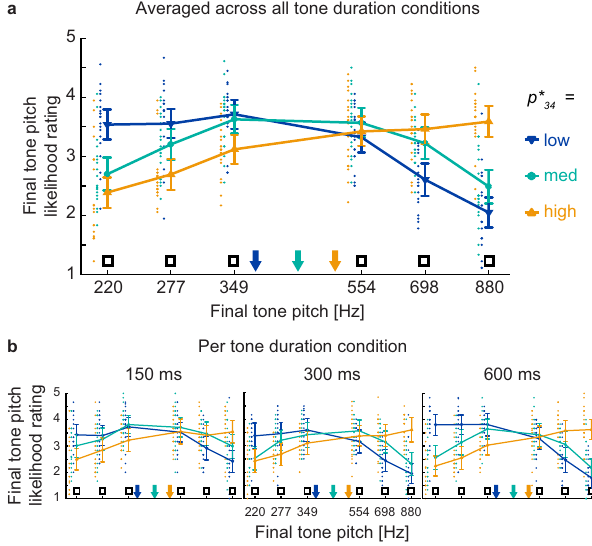
Fig. 2 Subjects ’ behavior demonstrates effective fi nal tone pitch prediction ( n = 20 participants). a Final tone pitch likelihood ratings averaged across all tone duration conditions. Final tone pitch likelihood rating ( y -axis; 1 = unlikely, 5 = likely) is plotted as a function of presented fi nal tone pitch ( p [empty black squares], x -axis) and theoretically 34 predicted fi nal tone pitch ( p (cid:2) ; color-coded). p (cid:2) tone pitch is indicated on 34 34 the x -axis by color-coded arrows. A repeated-measures ANOVA shows a signi fi cant interaction between p 34 and p (cid:2) [ F 2,46 = 36.96, p < 0.001, η 2 p = 34 0.66], indicated by the crossover of the blue and yellow lines. Dots represent individual participant data. Data are presented as mean ± SEM across participants. b Final tone pitch likelihood ratings per tone duration condition. Same format as a